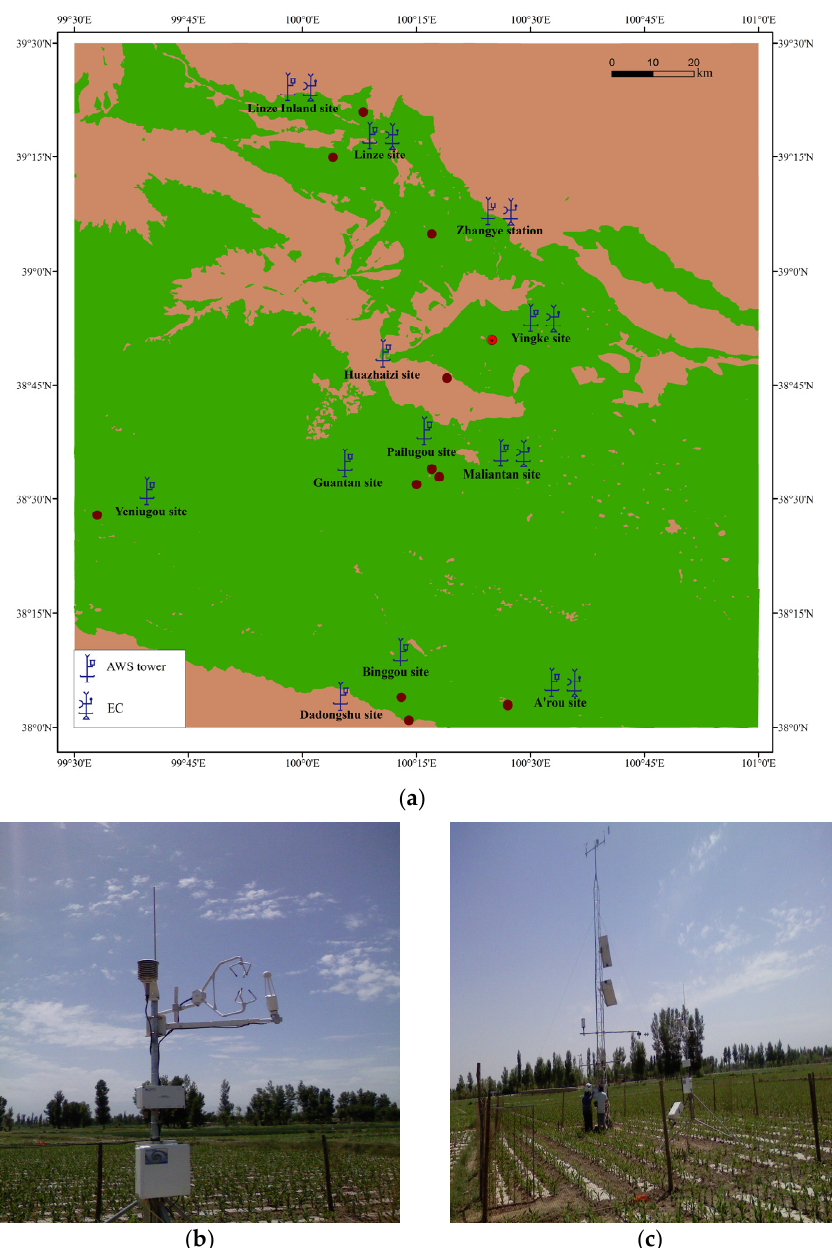
Figure 1. The Watershed Airborne Telemetry Experimental Research (WATER) experiment observation site locations ( a ), the eddy covariance (EC) system ( b ), and the automatic weather station tower (AWS-Tower) at the Yingke site ( c ).